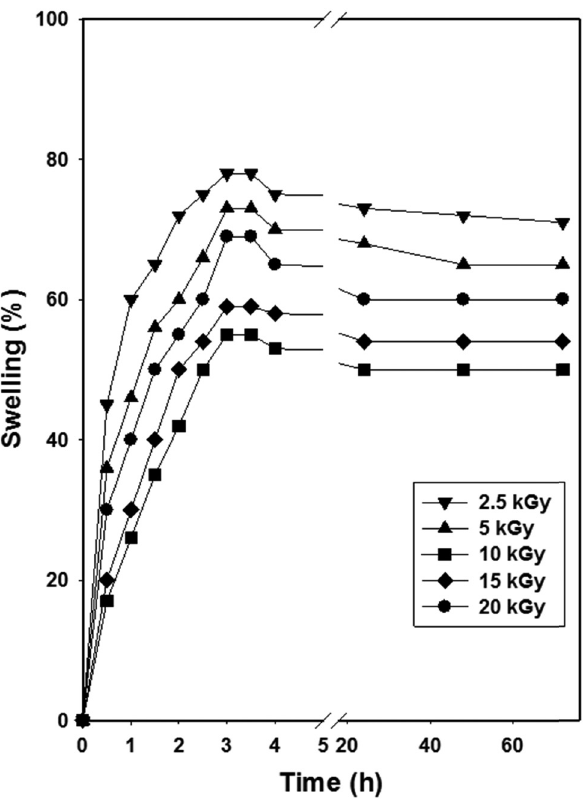
Figure 5: E ff ect of irradiation dose on the swelling percentage of ( PVP:CMC ) /CA/G/ZnO nano fi lms with a composition ratio of 2/1 and utilizing 1 wt% of ZnO.